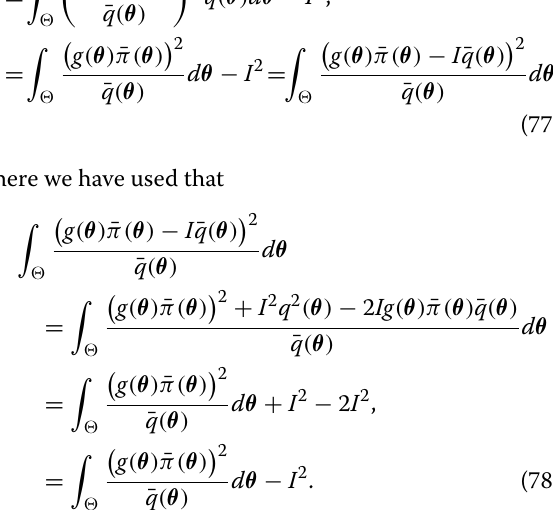
Algorithm 18 Generic Adaptive Population